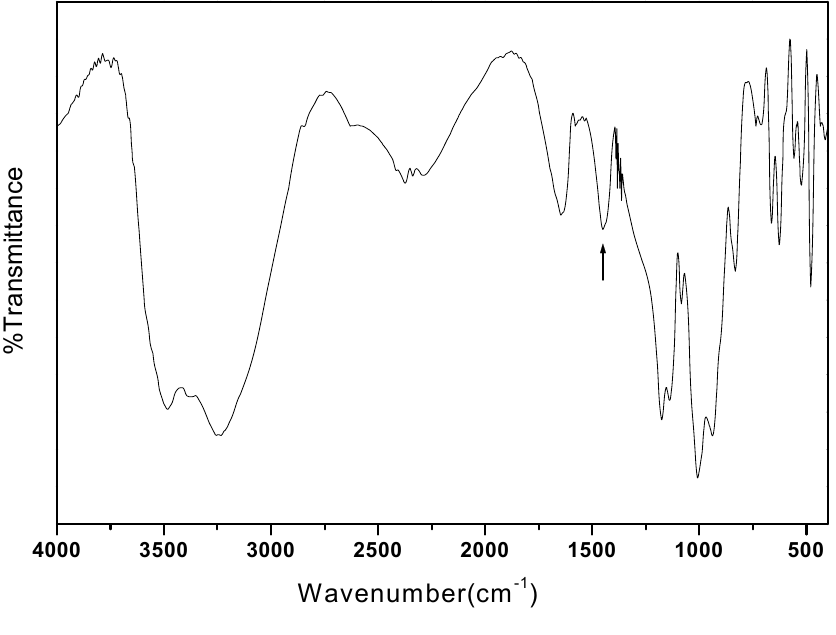
Fig. 2 FTIR spectra of (NH 4 ) 0 . 5 Mn 1 . 25 (H 2 O) 2 [BP 2 O 8 ] · 0.5H 2 O. The position of the υ 4 N-H deformation vibration is marked with